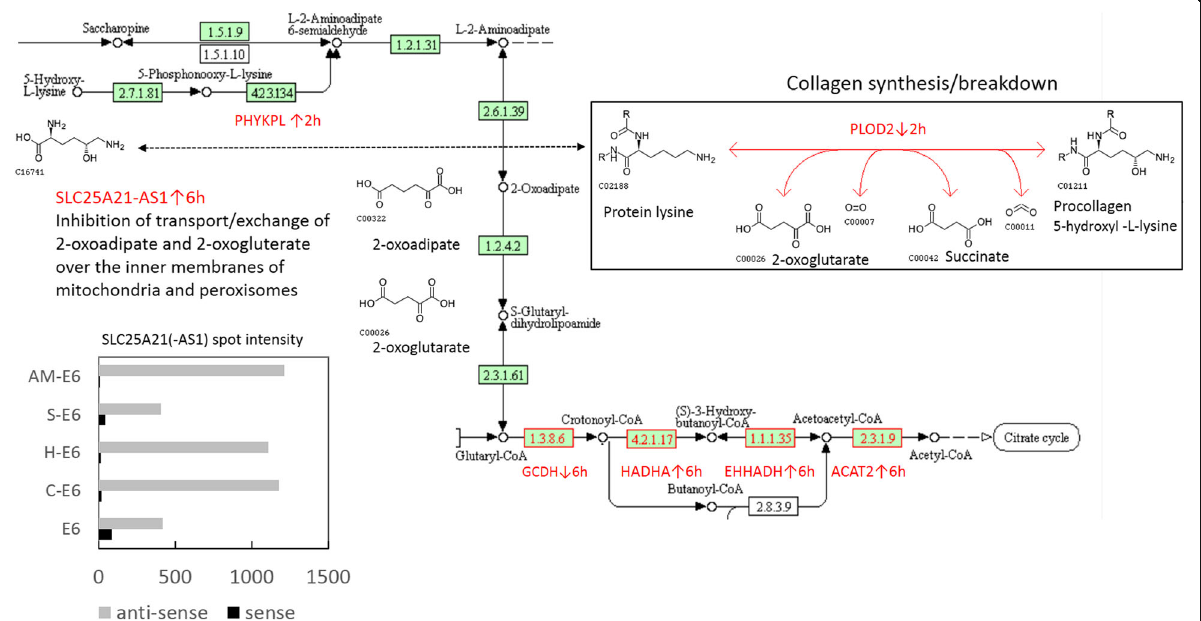
Fig. 4 Regulation of Acetyl-CoA production by β -oxidation of fatty acids in mitochondria and peroxisomes, and the interexchange of 2-oxodipate and 2-oxogluterate by SLC25A21 over the membrane of these organelles in cells. DEGs coding for enzymes involved in β -oxidation and in the catabolism of Procollagen 5-hydroxy-L-lysine residues that responded to mixtures of algae extracts and ETEC are highlighted in red in the original KEGG “ Lysine degradation ” pathway scheme. Graph: raw spot intensity of SLC25A21 (sense) and SLC2521-AS1 (anti-sense) probes on the micro